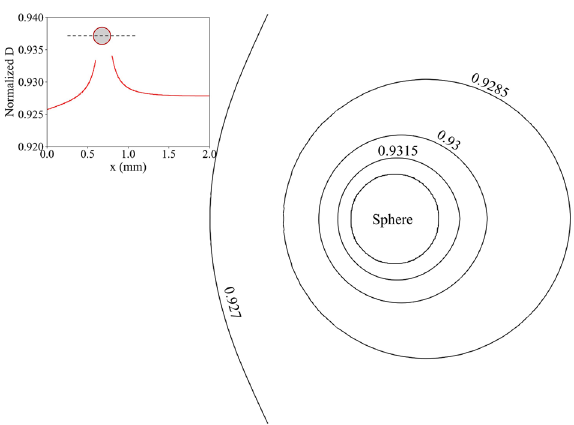
Figure 15. Normalized diffusion coefficient ( D / D 0 ) contour lines around a precipitating particle (insert: Normalized diffusion coefficient along the center line of the